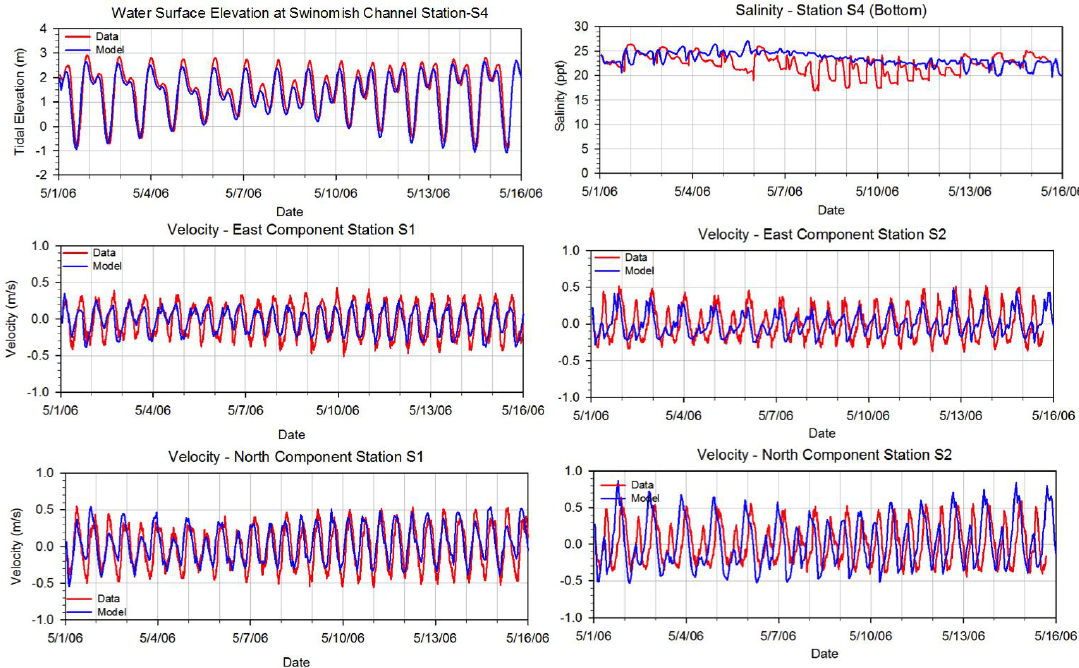
Figure 3. Comparison of observed tide, salinity, and currents in the Swinomish Channel (Figure 2b) shown as example at stations S1, S2, and S4 during May of 2006 as part of hydrodynamic model setup and calibration.